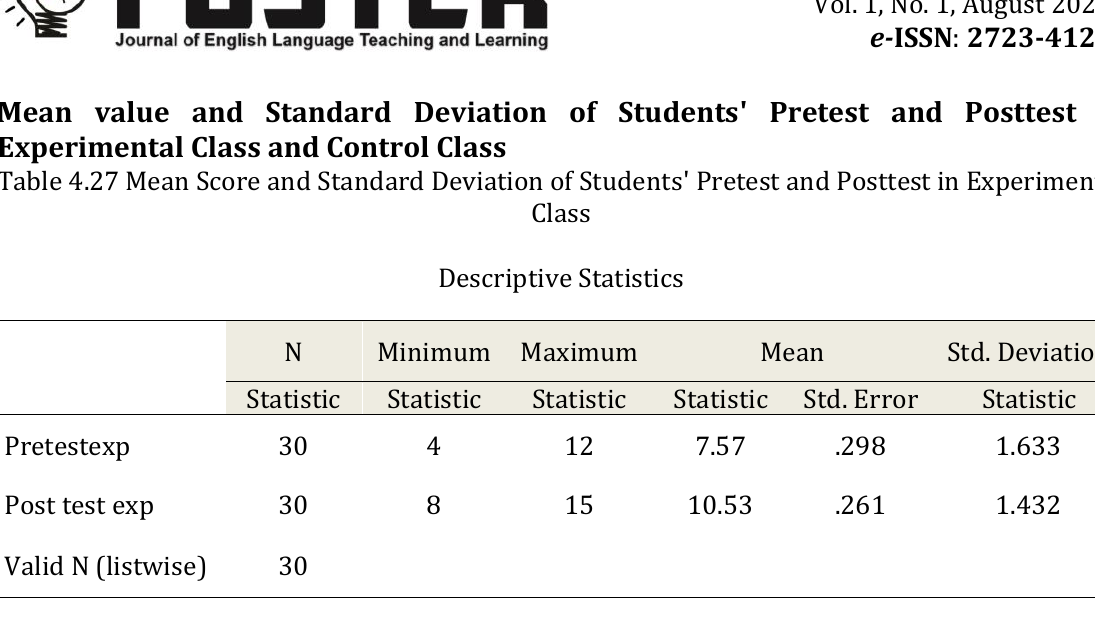
Table 4.28 Students' Result of t-test from Pre-Test score of Experiment and Control Classes